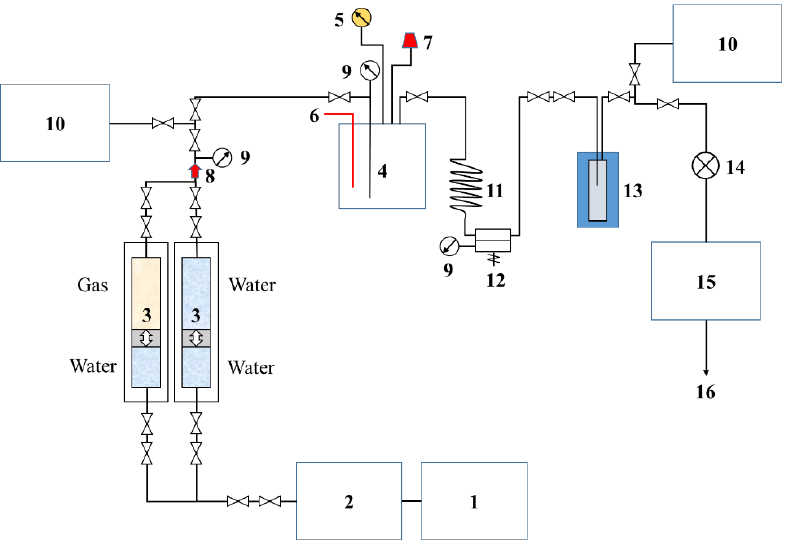
Figure 2. The scheme of autoclave installation used in experiments: 1 — computer; 2 — pump